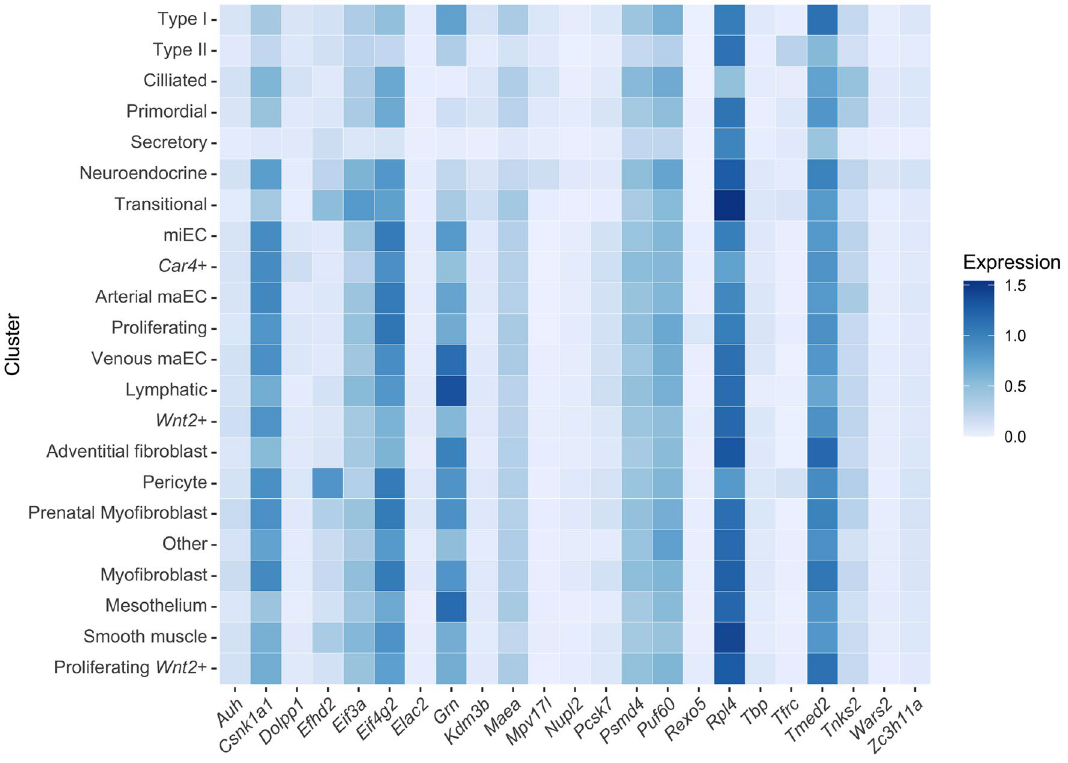
Figure 2. Marker gene expression was profiled in specific cell types by single-cell RNA sequencing. From the single-cell sequencing atlas of mouse lung development 18 , expression across the different cell types was averaged from mouse lungs collected at P0, P3, P5, P7 and P14 and plotted on a heatmap. Darker colors indicate greater expression.